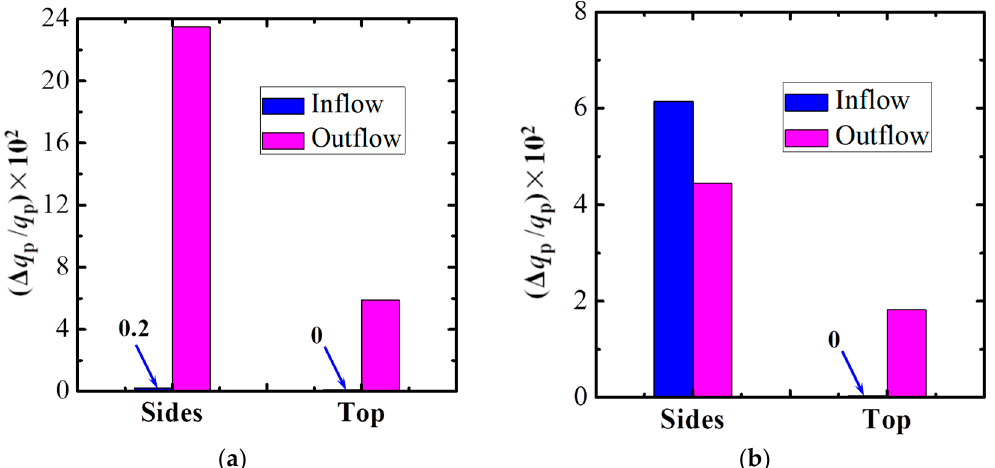
Figure 15. Total pollutant flow rates at the boundaries of the PSC and TSC (GH-30): ( a ) PSC; ( b ) TSC.